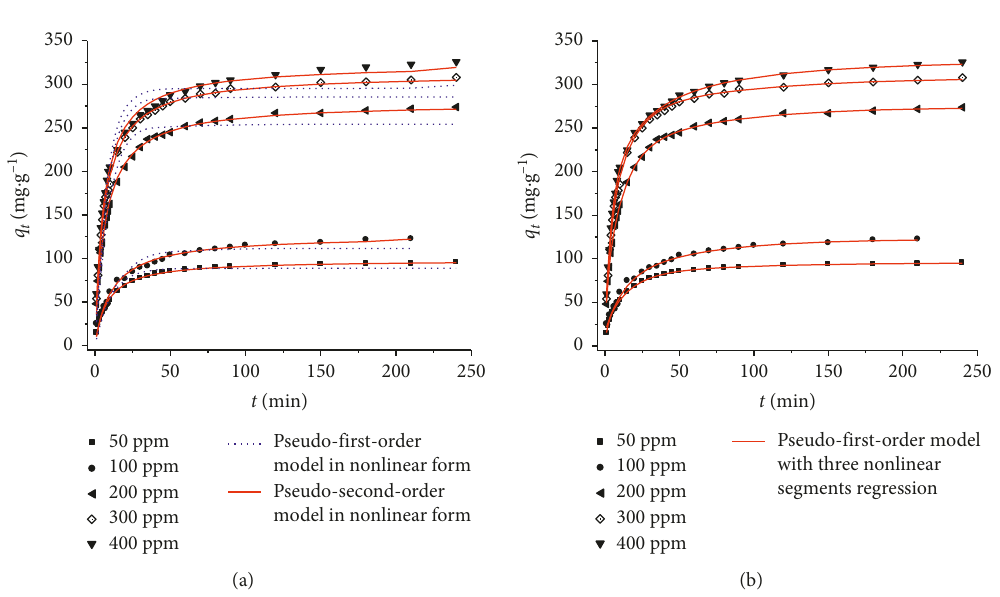
Figure 5: (a) Plots of pseudo-first- and pseudo-second-order adsorption kinetics; (b) plots of three pseudo-first-order adsorption kinetics of RDB on